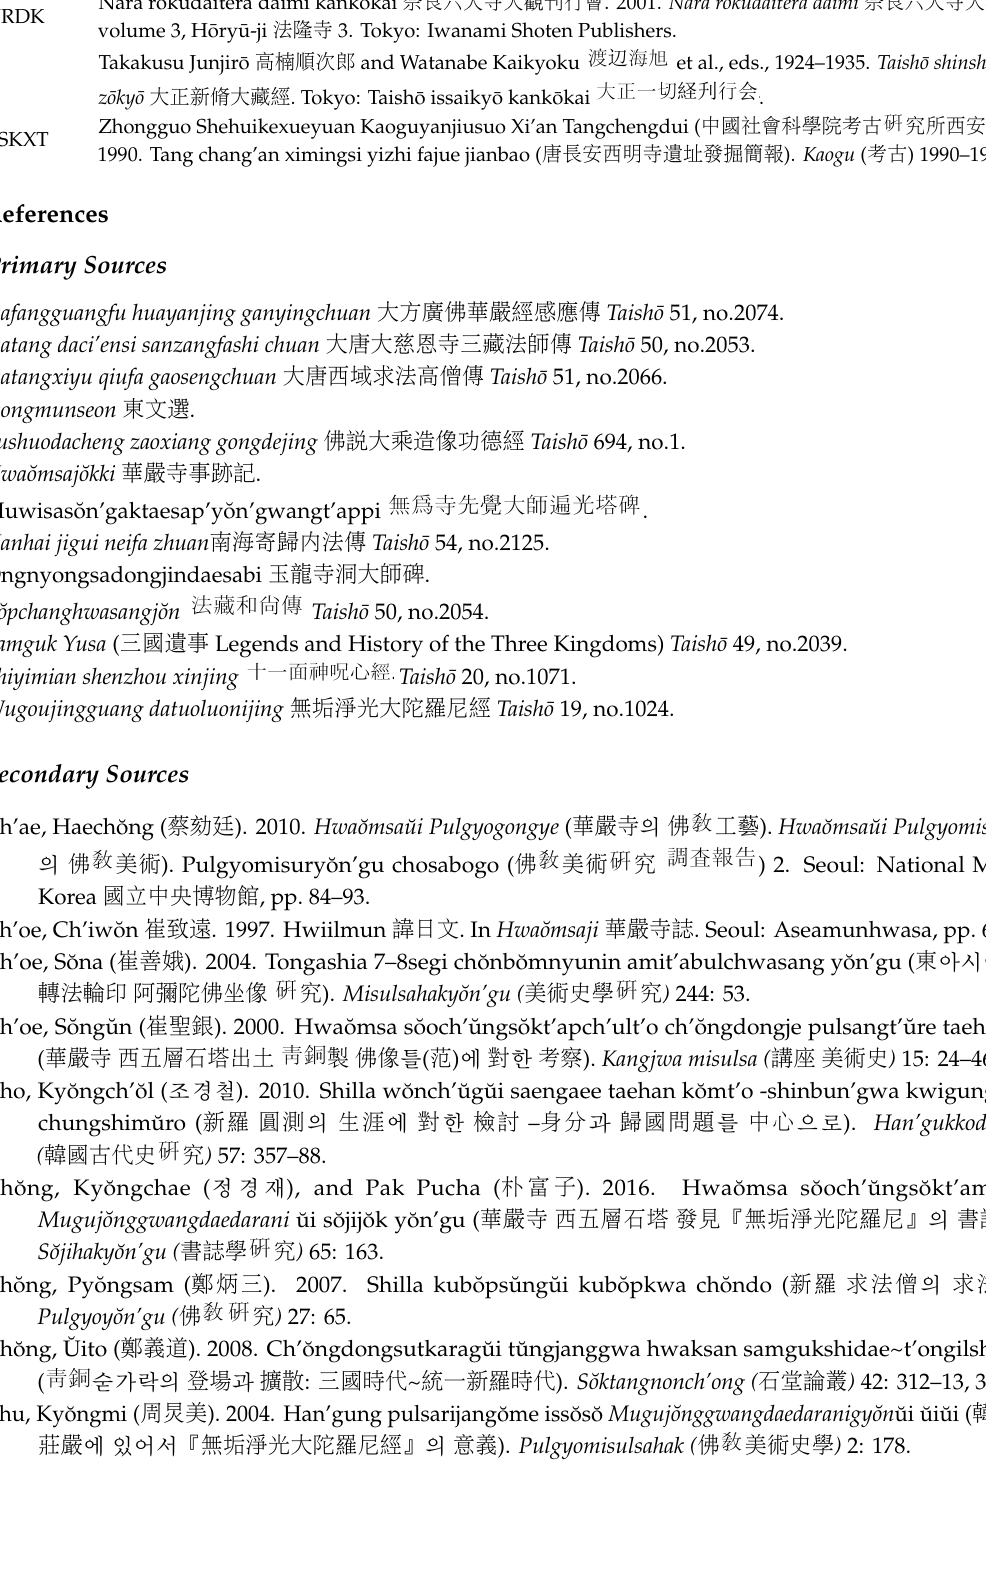
Figure 20. Clay Buddha, Pagan period, 12th–13th centuries, 9.6 × 7.1 cm, Myanmar [Source: (Fukuoka Art Museum 2008, cover picture)]. Figure 17. Clay Buddha, Unified Silla, 8.3 × 7.3 cm, An’gang Kapsan-ri temple site, Ky ŏ ngju, Korea